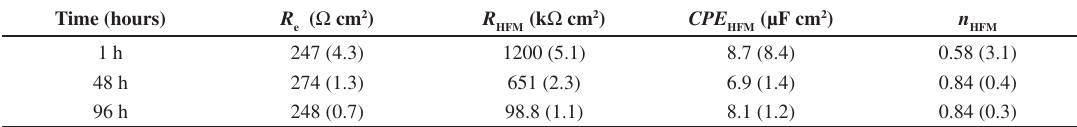
Table 7. Electrical elements fitted values for F1P90M film up to 96 h of immersion in 0.05 M NaCl solution. The error % associated with each parameter value is given in parenthesis.